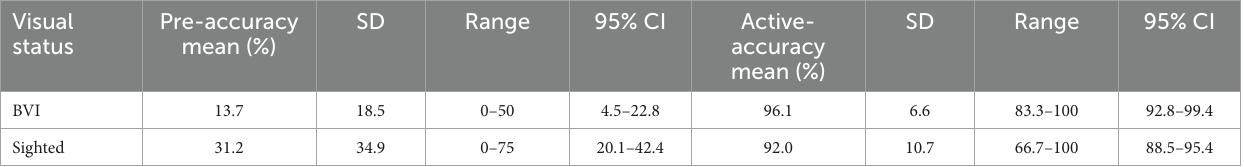
TABLE 3 Pre/post accuracy collapsed across diagram and